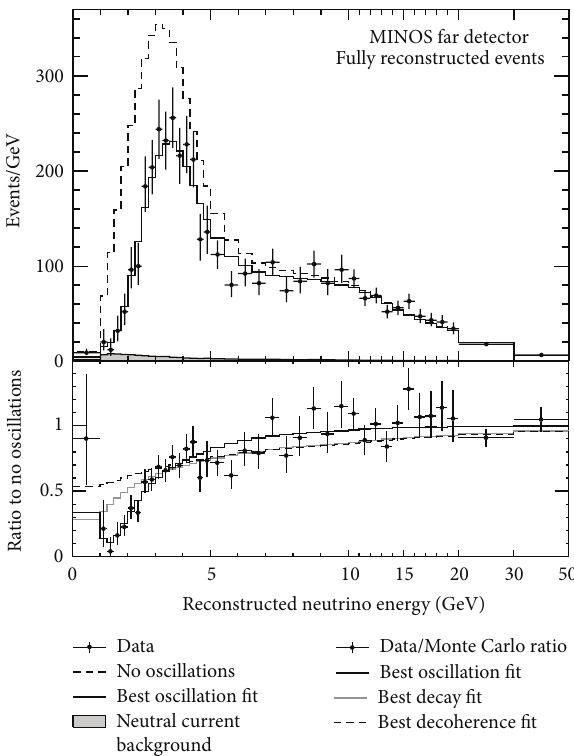
Figure 12: The energy spectrum of fully reconstructed muon neutrino candidate events in the MINOS Far detector (a). Both the no oscillation hypothesis and the best oscillation fit are shown. The shaded region shows the expected neutral-current background. The ratio to no oscillations (b) displays the best fits to models of neutrino decay and neutrino decoherence, where they are seen to be disfavored at high significance (7 𝜎 and 9 𝜎 , resp.)